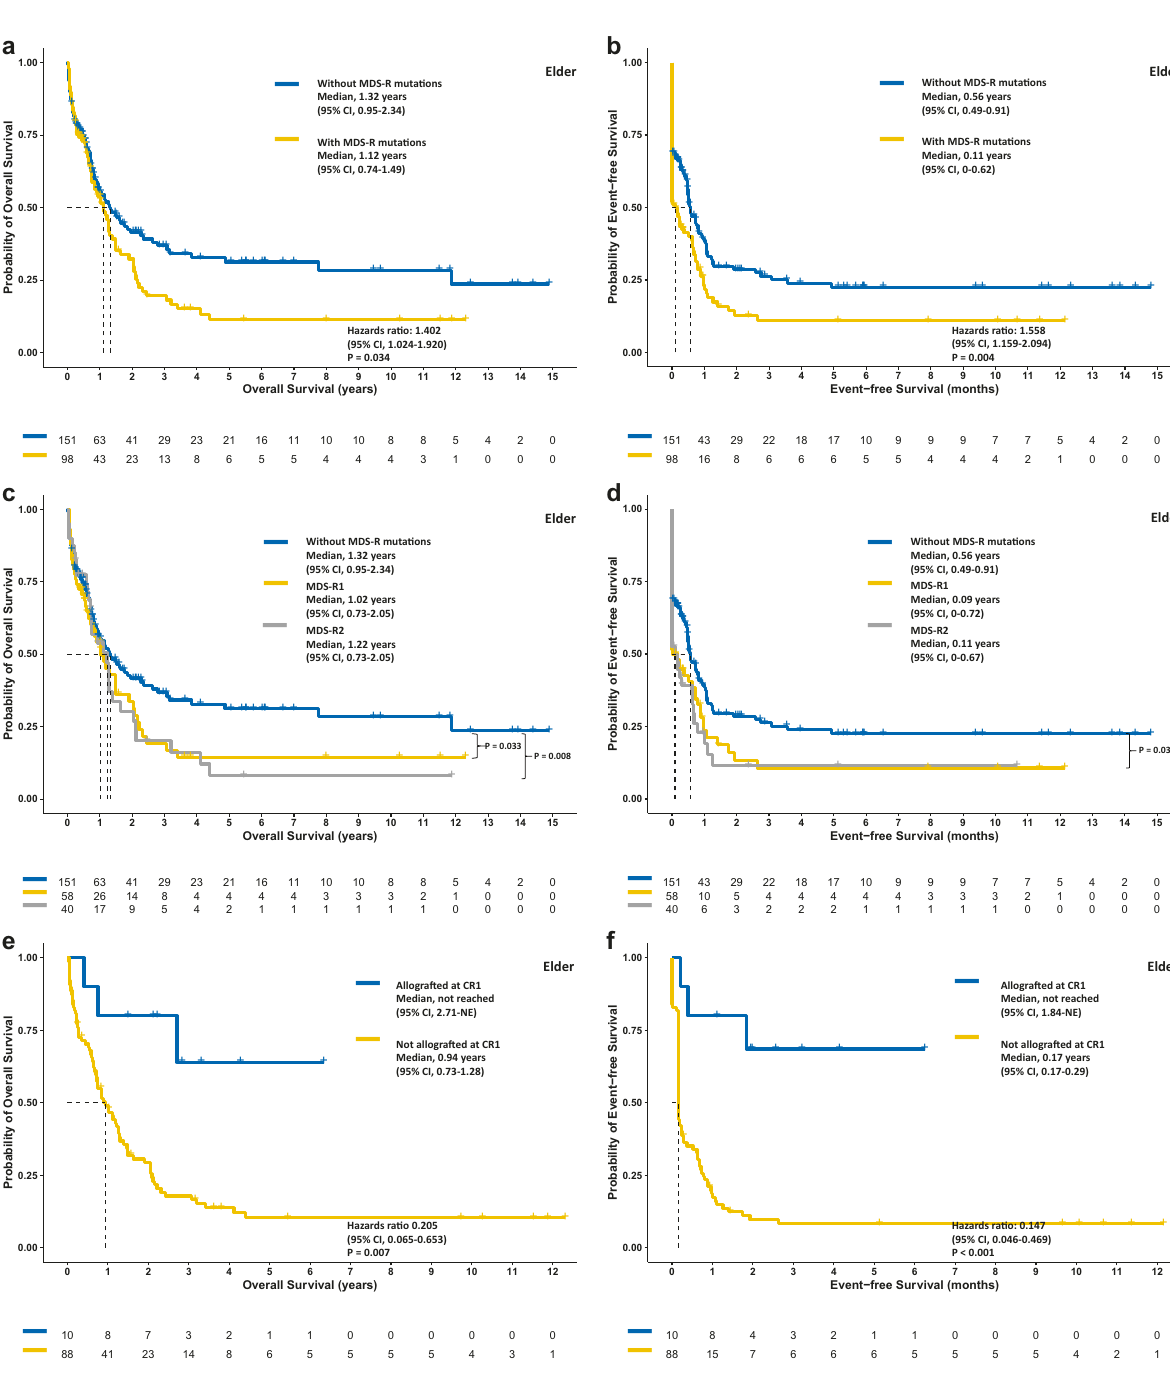
Fig. 3 The Kaplan ‒ Meier survival curves for the elderly patient cohort. OS ( a ) and EFS ( b ) strati fi ed by the status of MDS-R mutations, the MDS-R mutation burdens ( c and d , respectively), and treatment with or without allogeneic transplantation at fi rst remission ( e and f , respectively). Patients with MDS-R mutations might bene fi t from allogeneic transplantation. MDS-R1, with one MDS-R mutation; MDS-R2, with 2 or more MDS-R